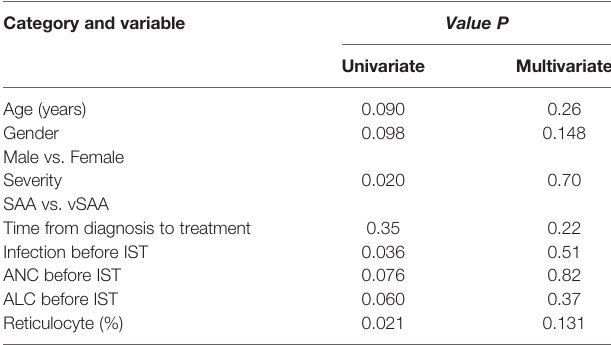
TABLE 2 | Factors related to the ef fi cacy at 6 months after IST with univariate and multivariate